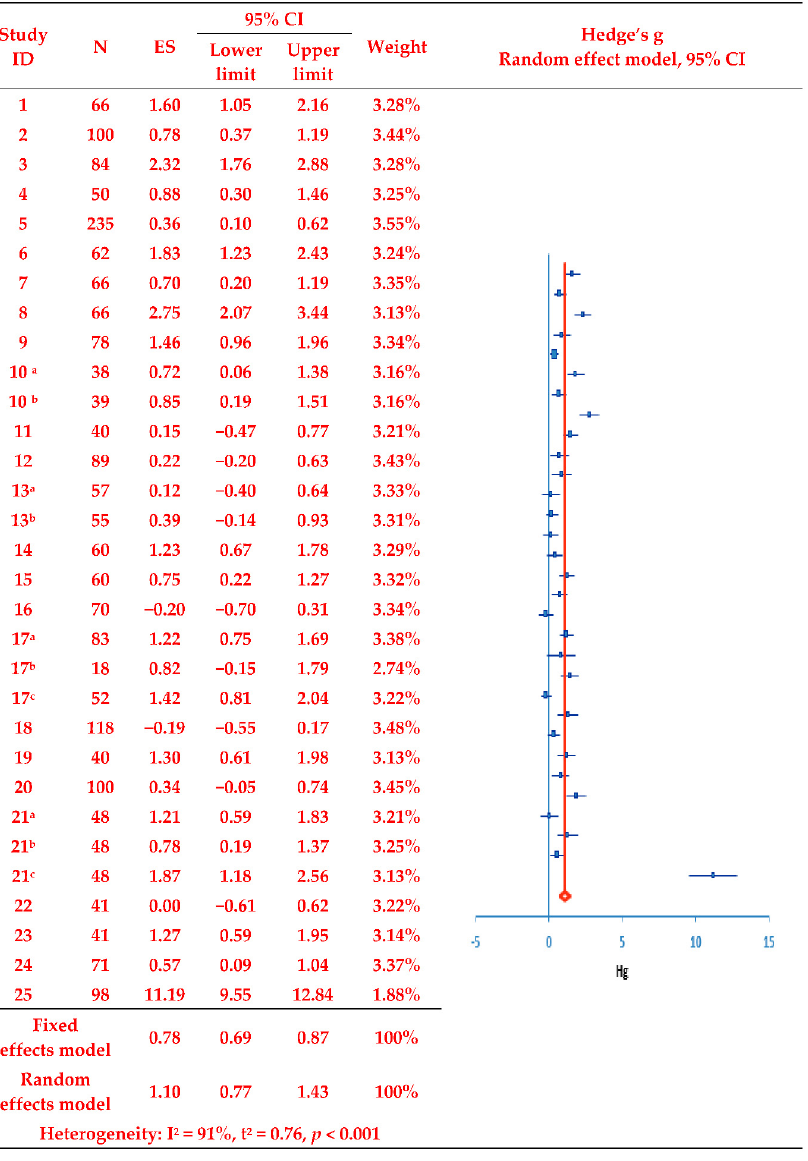
Figure 2. Effects of the evaluated intervention programs on treatment adherence. Duplicate removal of the number of participants in the study of [17–20]. Studies with two or more experimental groups are marked with a, b, and c for classification. N, number of subjects; ES, effect size; CI, Confidence interval; Hg, Hedge’s